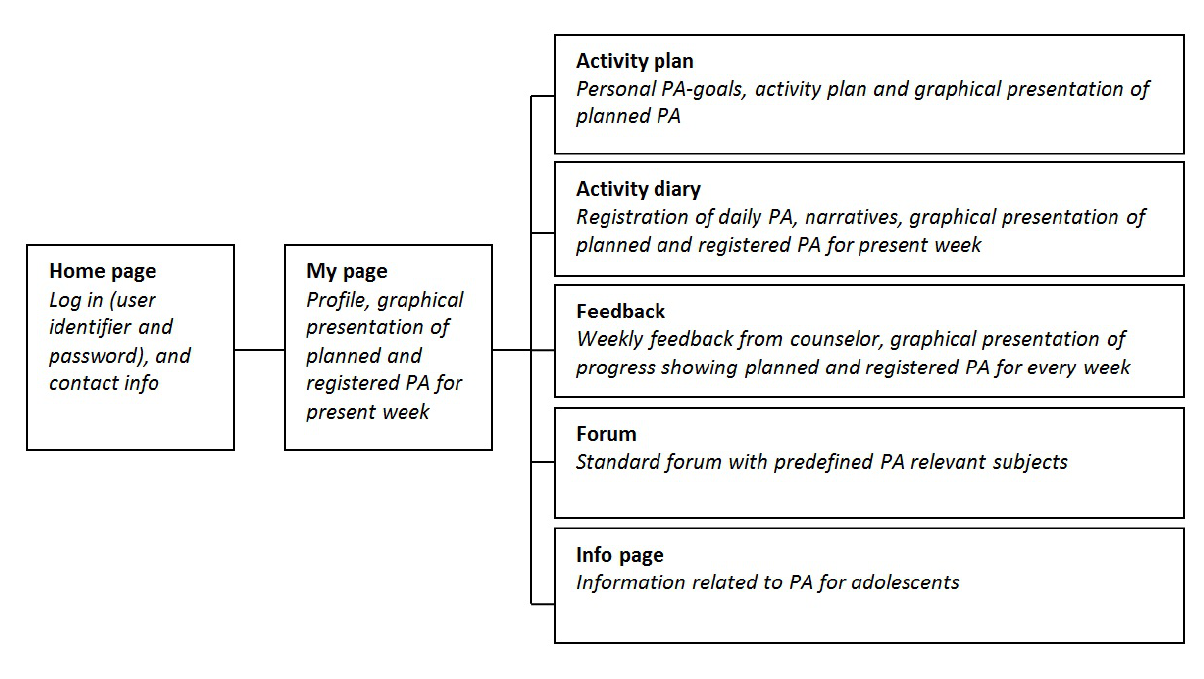
Figure 2. Main content and interactive features of Young &